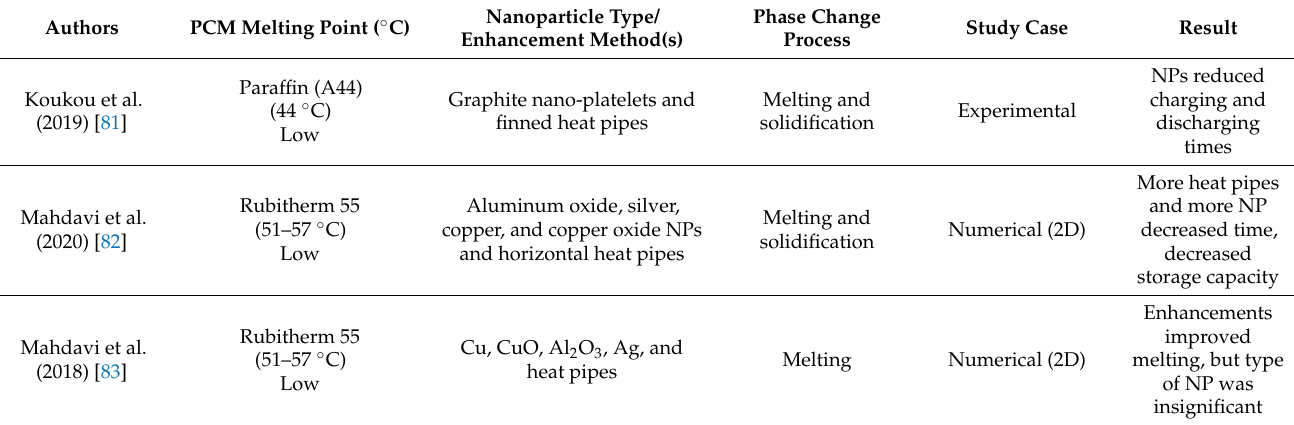
Table 3. A summary of studies that used NePCM combined with heat pipes to enhance the LHTES system. Authors PCM Melting Point ( ◦